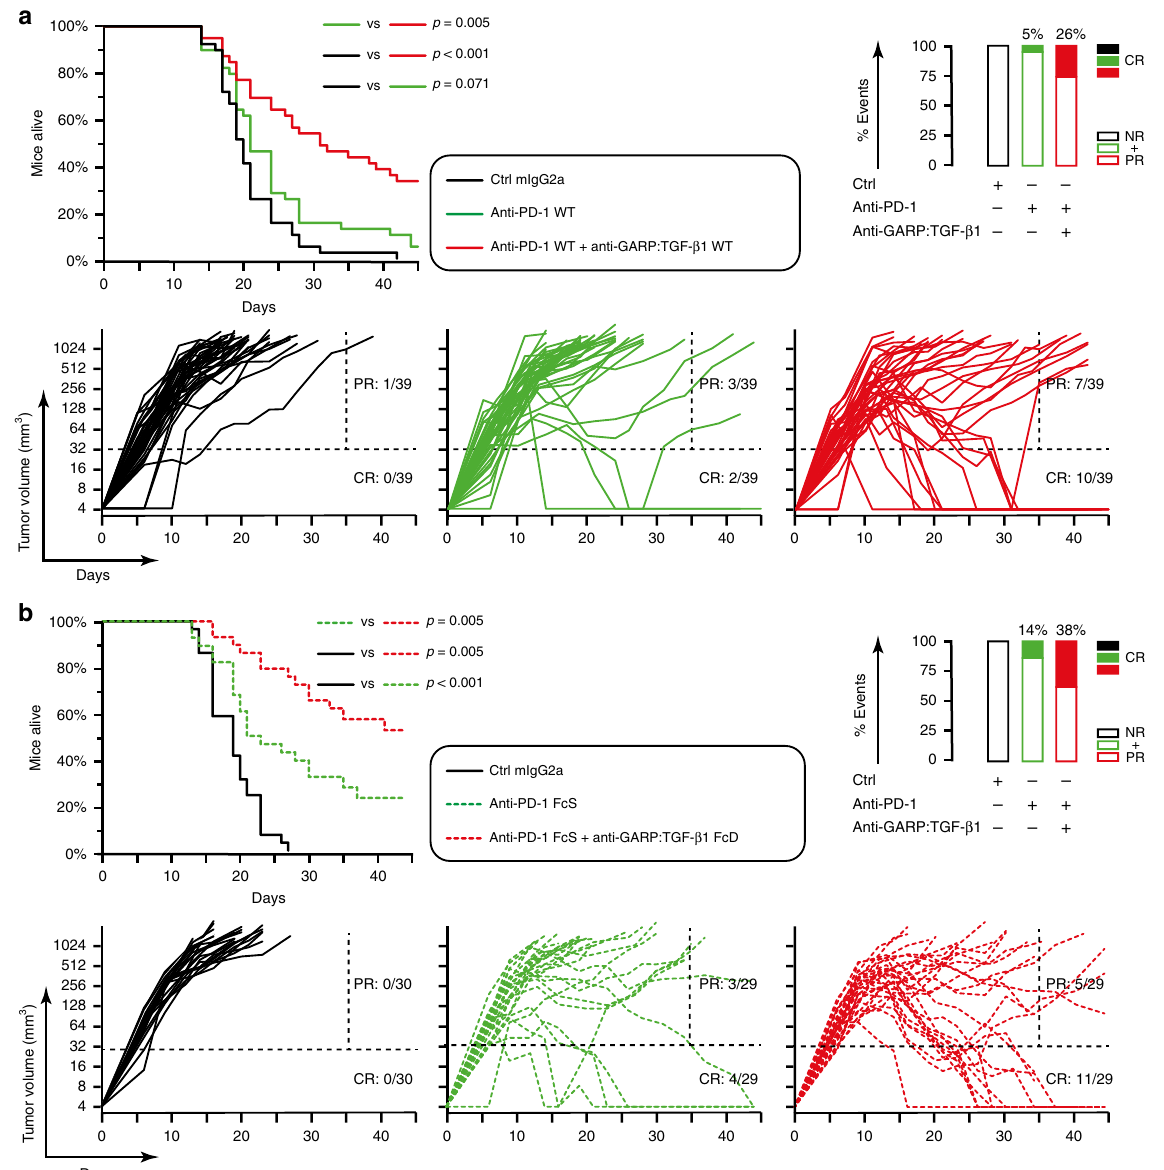
Fig. 3 Combined blockade of GARP:TGF- β 1 and PD-1 shows anti-tumor ef fi cacy against established CT26 tumors. BALB/c mice were injected s.c. with live CT26 cells on day 0. Tumor diameters were measured two to three times a week. On day 6, mice were randomized in various experimental groups and received the fi rst of 3 – 4 mAb injections. Mice were euthanized when the tumor surface was ≥ 200 mm 2 . a Meta-analysis of four pooled independent experiments in which mice received anti-PD-1 WT alone, or in combination with anti-GARP:TGF- β 1 WT ( n = 39). b Meta-analysis of three pooled independent experiments in which mice received anti-PD-1 FcS alone, or in combination with anti-GARP:TGF- β 1 FcD ( n = 29 – 30). a , b Kaplan Meier plots on top represent the proportions of mice alive during the experiment, with P values calculated using a one-tailed Wilcoxon test. Graphs on bottom represent evolution of tumor volumes in various groups (each line represents one mouse). Ratios indicate the proportions of CR and PR, as de fi ned in Fig. 2. Rectangles on the right represent proportions (%) of CR ( fi lled rectangles), and partial + non-responders (PR + NR, empty